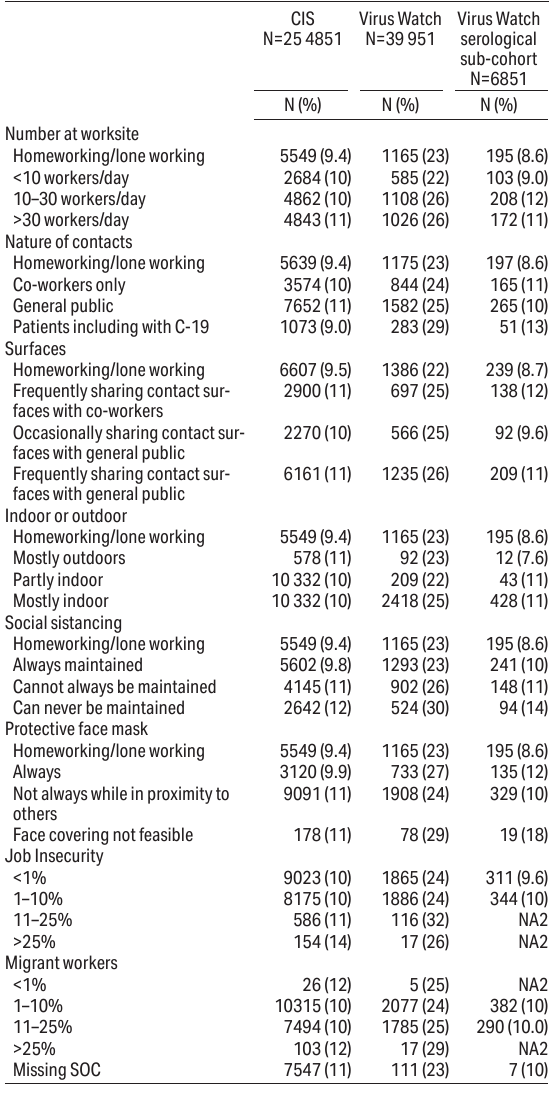
Table 3. Participants with at least one infection by JEM domain by risk level for the COVID-19 Infection survey (CIS) and two Virus Watch cohorts (full cohort and serological sub-cohort). See table 1 for domain descriptions. [NA2=suppressed for statistical disclosure control due to small cell size; SOC= Standard Occupational